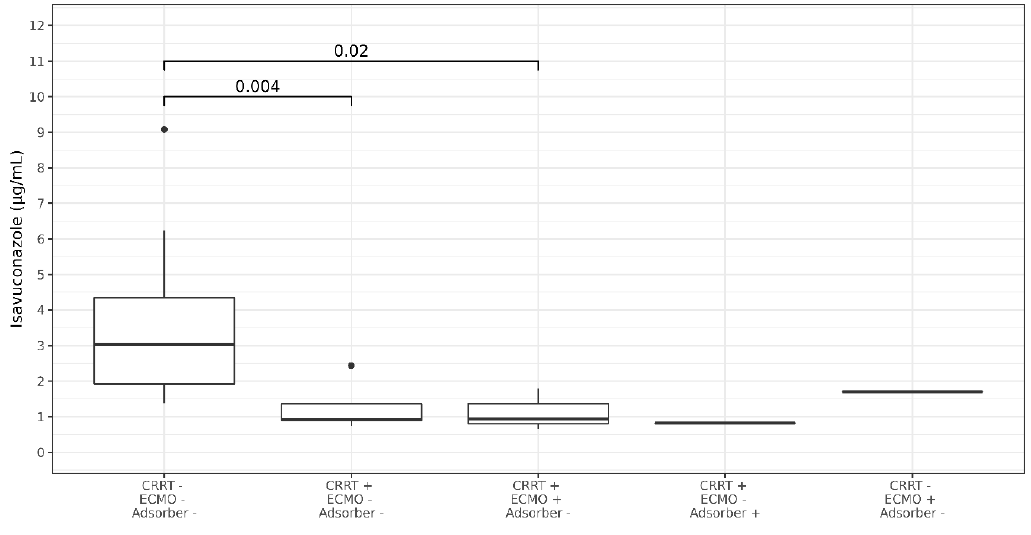
Figure 1. Boxplots showing median Isavuconazole trough plasma concentration in patients with and without extracorporeal treatments. CRRT = renal replacement therapy, ECMO = extracorporeal membrane oxygenation, adsorber = cytosorb adsorber. P -Values are shown above the brackets. Dots represent outliers.